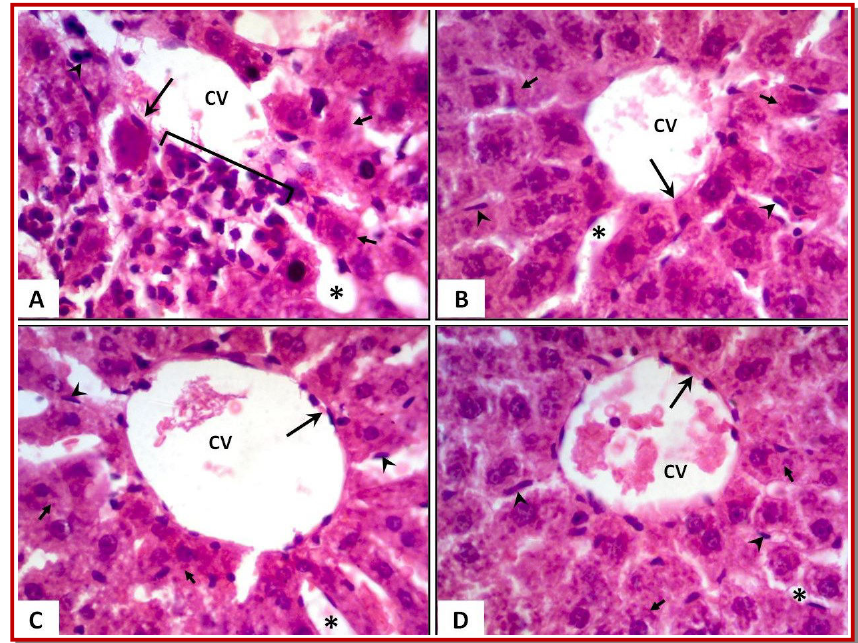
Figure 1: Histopathological evaluation of isoniazid plus rifampicin induced hepatotoxicity pretreated with M. buxifolia for 21 days (H and E; x400 original magnification). (A): Photomicrograph of a section of liver from a rat treated with isoniazid plus rifampicin showing congestion of the central vein (CV) with disruption of its endothelium (large arrow), dilatation of the sinusoidal spaces (asterisk), infiltration (arrow head) as well as aggregation (bar) of lymphocytes around the central vein and necrosis of hepatocytes (small arrows). Normal histology of central vein (CV) with intact endothelium (large arrow), hepatocytes (small arrows) and si- nusoidal spaces (asterisk) lined by endothelial cells (arrow heads) were observed in groups of rats treated with (B): M. buxifolia (150 mg/kg) (C): M. buxifolia (300 mg/kg) and (D): silymarin (100 mg/kg) one hour before administration of isoniazid plus rifam-